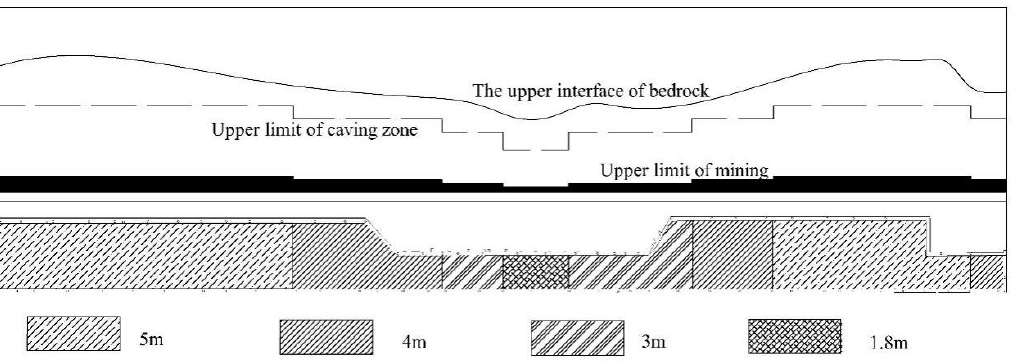
Figure 13. Schematic of mined thicknesses of coal at the working face. Not upper limit — upper boundary in diagram.